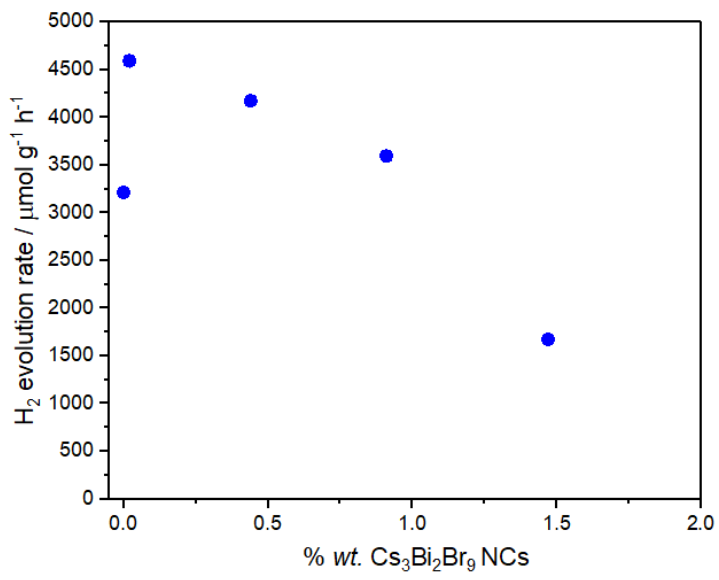
Figure 5. Hydrogen evolution reaction of the Cs 3 Bi 2 Br 9 NCs/g ‐ C 3 N 4 NSs composites observed at different percentages of perovskite loading (wt . %); conditions: 10 v/v %TEOA aqueous solution, 1 g L − 1 catalyst, 3 wt . %Pt as co ‐ catalyst, simulated solar light (6 h, 500 W m − 2 ); RSD < 10% ( n = 3).